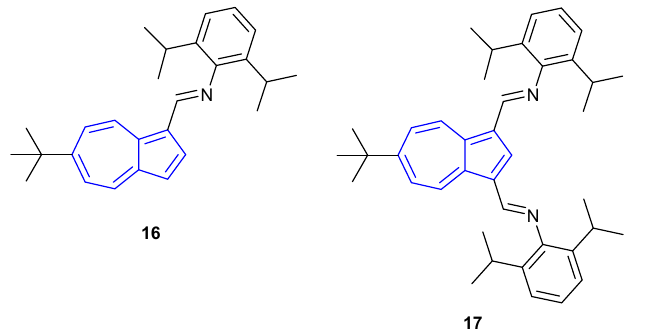
Figure 12. The 1- and 3-connected azulenes described by Jamali, Bagherzadeh and co-workers [59]. Fluorescence sensing for specific analytes, outside of azulene protonation, is scarce. In 2005, Eichen et al. published a “turn-on” fluorescent azulene sensor for fluoride [60]. The sensor, 1,3-di(2-pyrrolyl)azulene 18 , was found to be selective towards tetrabutylammo- nium (TBA) fluoride over other TBAX salts in both DMSO and DCM (where X = Cl − , Br − ,